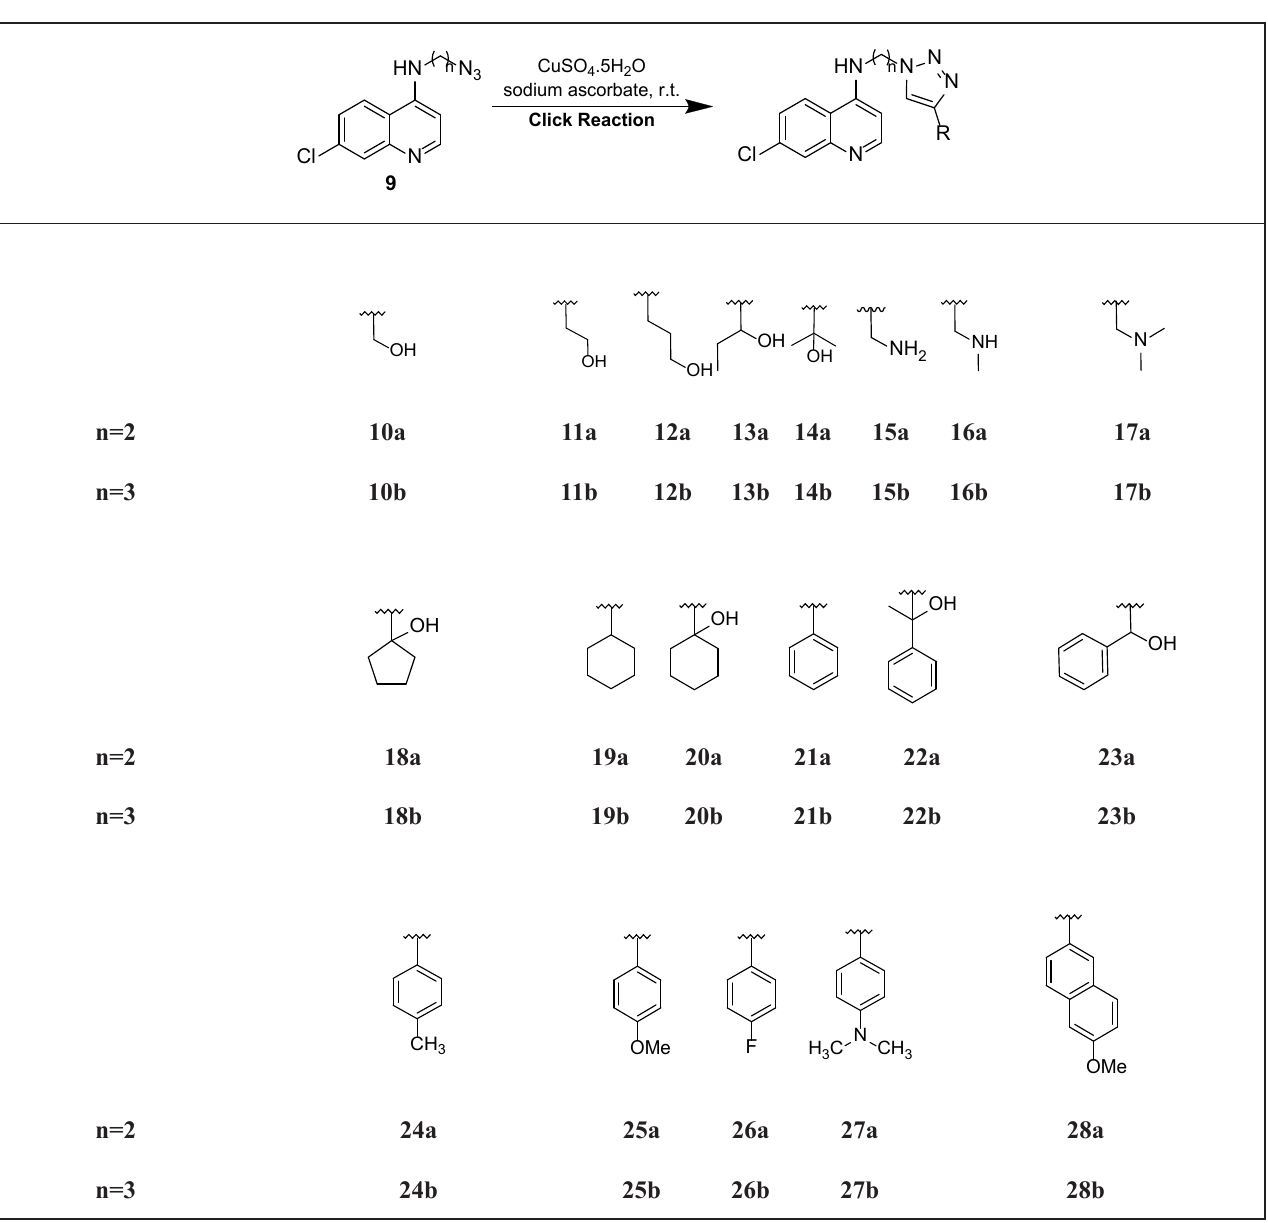
FIGURE 3 – Obtainment of quinolyl triazole hybrids via click